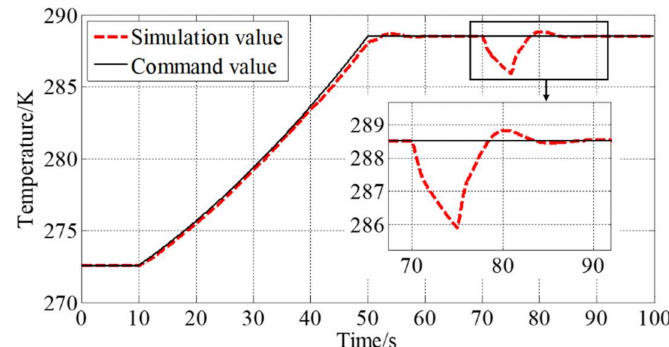
Figure 24. Temperature change of outlet air flow.